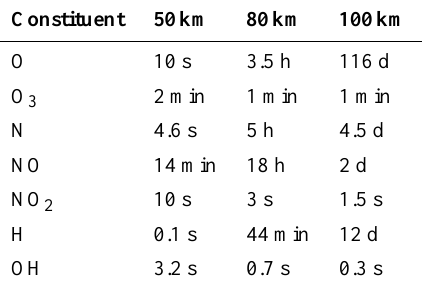
Table 5. Photochemical time constants at noon (Shimazaki, 1984)